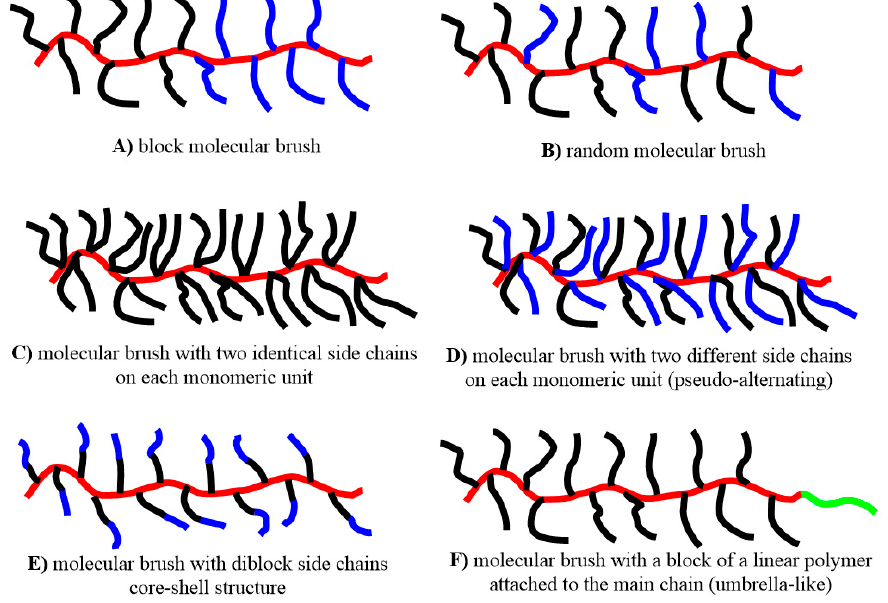
Figure 4. A few advanced macromolecular architectures of molecular brushes.